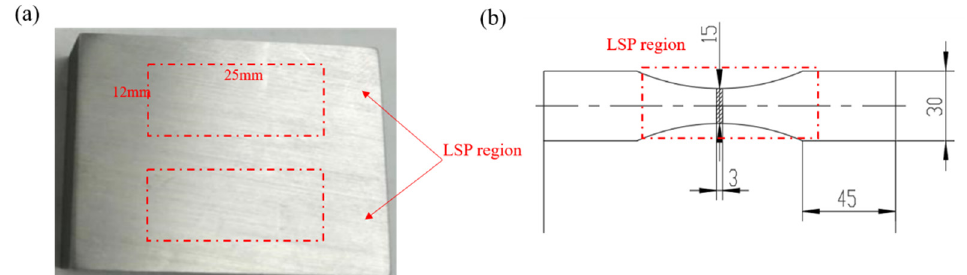
Figure 1. ( a ) TC6 titanium samples, ( b ) laser shock peening (LSP)-treated zone.